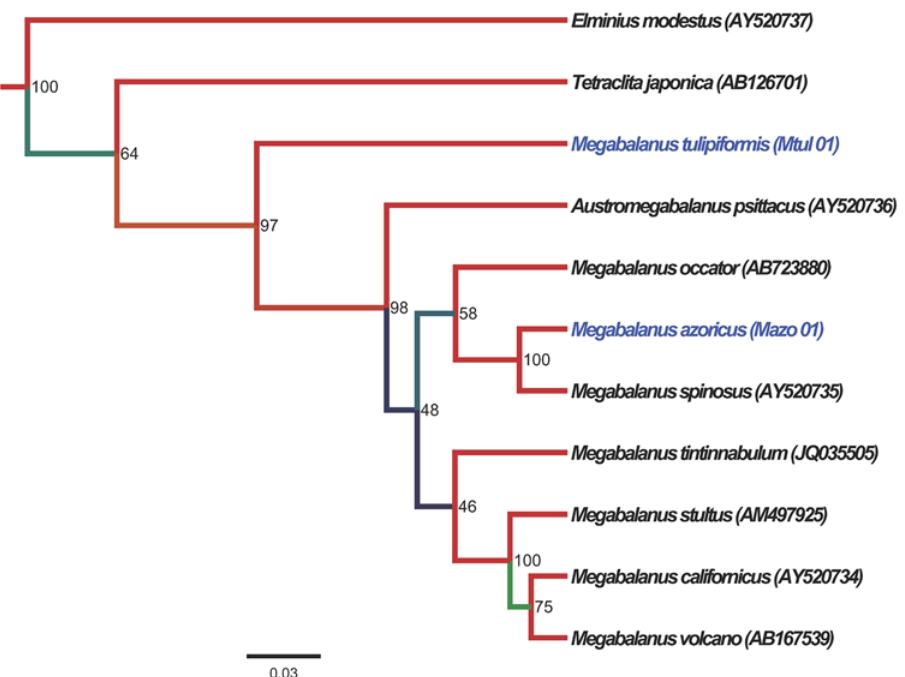
Fig 3. Phylogenetic tree within the Megabalanus genus. Phylogenetic tree based on the Bayesian criterion and elaborated with MrBayes from 16SrRNA sequences with distance calculated by the GTR model. Megabalanus sequences available from Genbank were included in the analysis, which incorporated 16S rRNA sequences obtained from M . tulipiformis and M . azoricus specimens (in blue color). Branch support is indicated by the numbers on branches, reflecting the Bayesian analysis posteriori probabilities in percentages. The Elminius modestus sequence was used as an